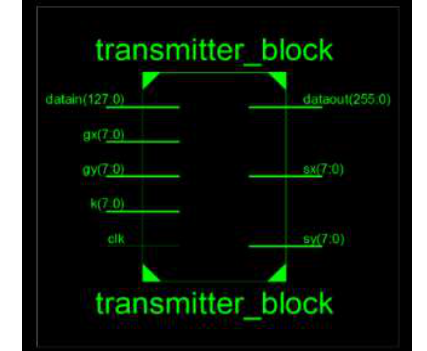
Figure 7 . Top module of Cryptoprocessor Transmitter